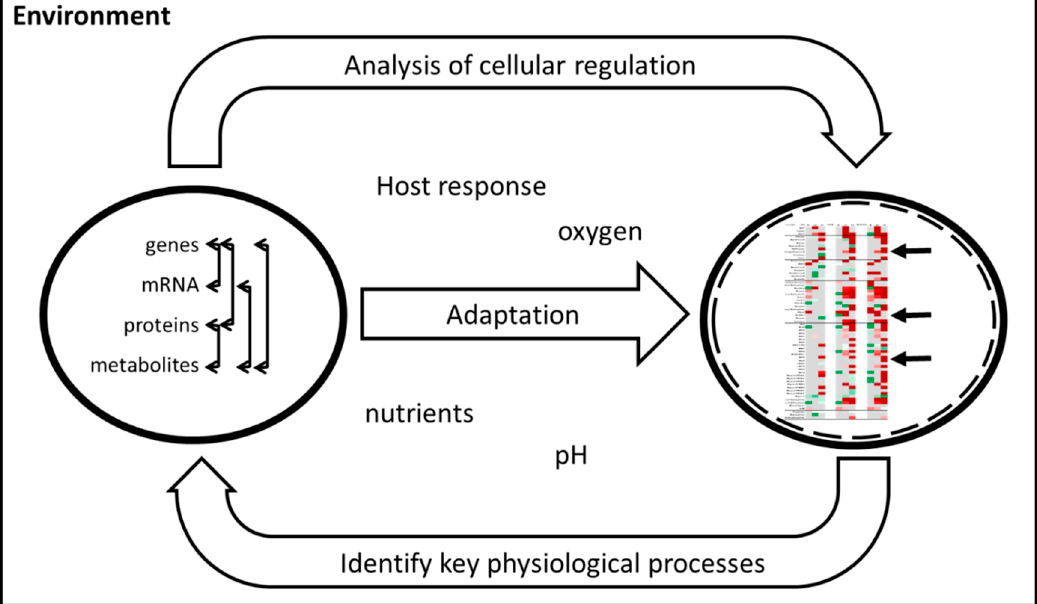
Figure 2. Role of systems biology in understanding key physiological processes of the TB bacilli and intracellular regulation under adaptation to the environment. Arrows represent interaction of intracellular regulation molecules (left circle) and changes of metabolites (right circle).